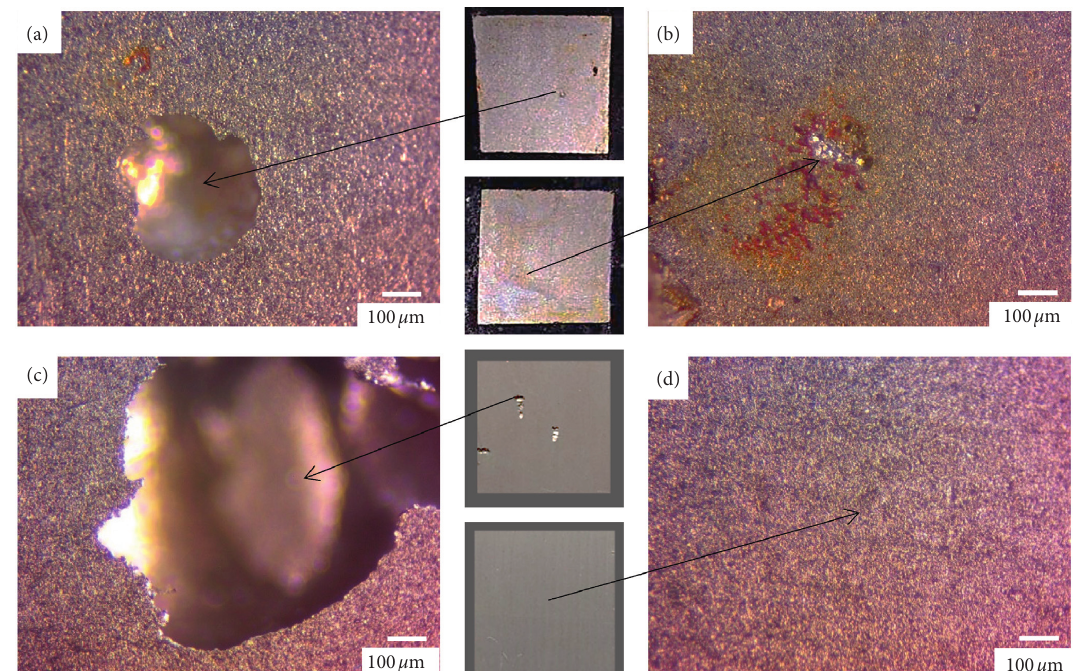
Figure 5: The surface of AISI 316 steel after galvanostatic (a, b) and potentiostatic (c, d) polarization in conditions of ultrasound vibration (b, d) and without vibration (a, c). Ultrasound parameters: frequency 27 kHz; power 10W.